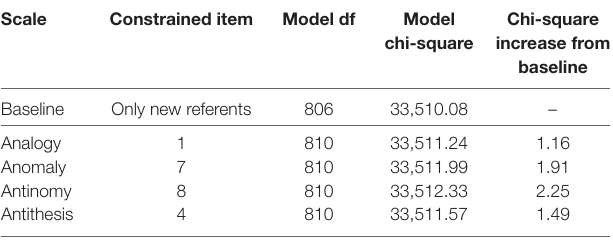
taBlE 9 | Likelihood-ratio tests for differential item functioning between white and hispanic participants: testing referents.